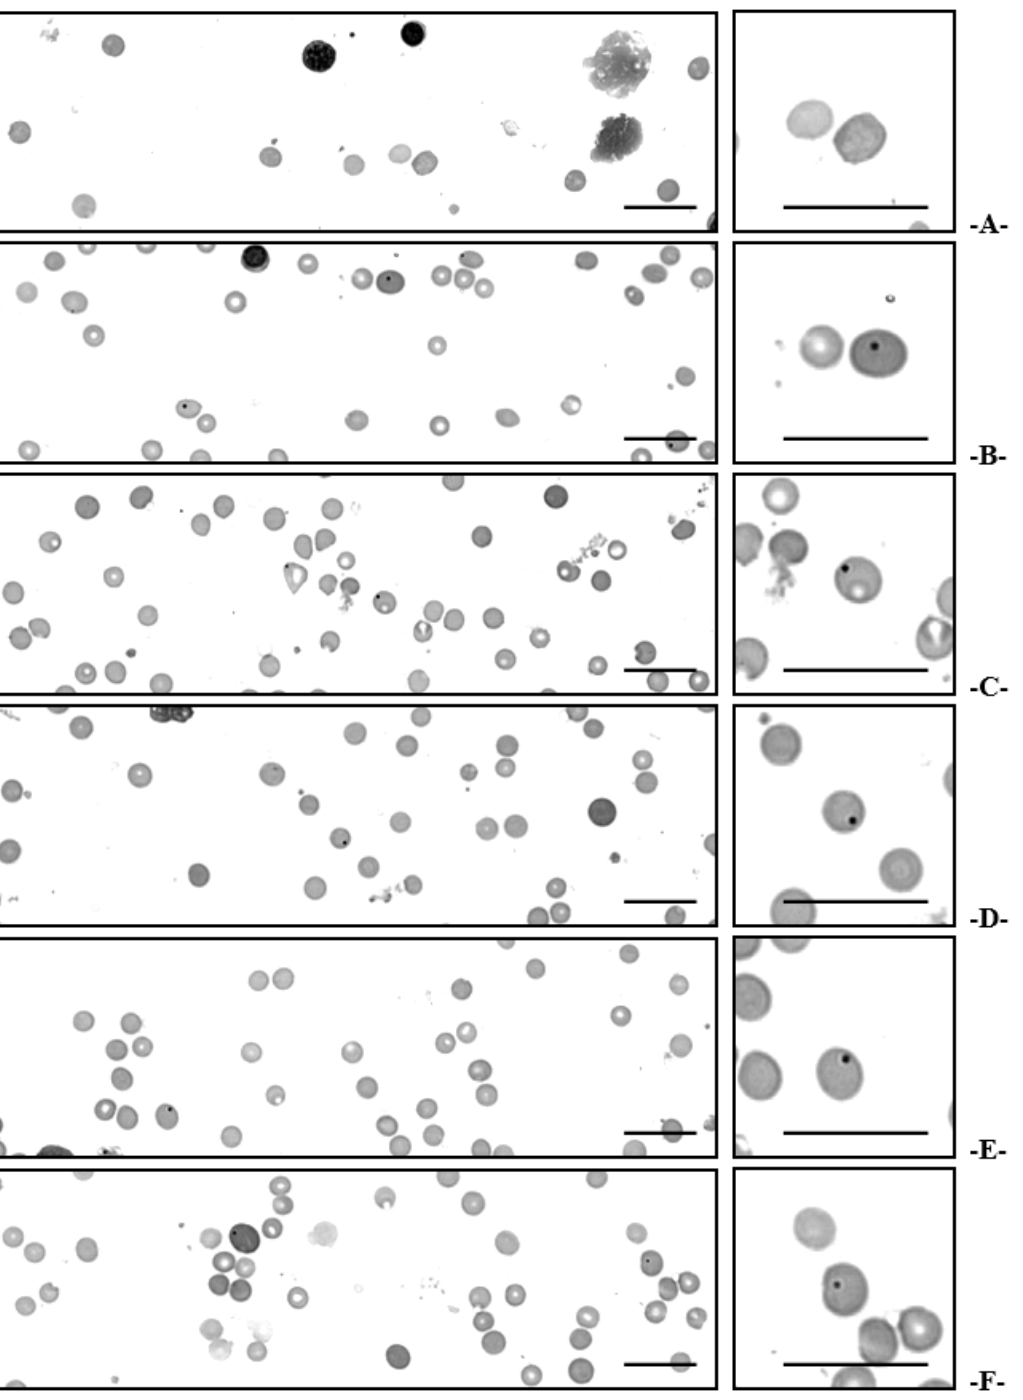
Figure 5. Representative cell smear cytological images of the bone marrow cells collected from individual mice in each group upon euthanasia. ( A ) Intact vehicle control: distilled-water administered intact mice; ( B ) CPA control: cyclophosphamide-treated and distilled-water administered control mice; ( C ) EAP 200 : CPA treated and A. pullulans purified exopolymers (EAP at a dose of 200 mg/kg) administered mice; ( D ) AR 400 : CPA treated and AR (400 mg/kg) administered mice; ( E ) AR 200 : CPA treated and AR (200 mg/kg) administered mice; ( F ) AR 100 : CPA treated and AR (100 mg/kg) administered mice; AR = Astragali Radix (Roots of A. membranaceus Bunge) extracts; PCE = Polychromatic erythrocytes; MN = Micronucleus; NCE = Normochromatic erythrocytes; MNPCE = MN contained PCE; all May-Grunwald and Giemsa stain; scale bar = 20 µ